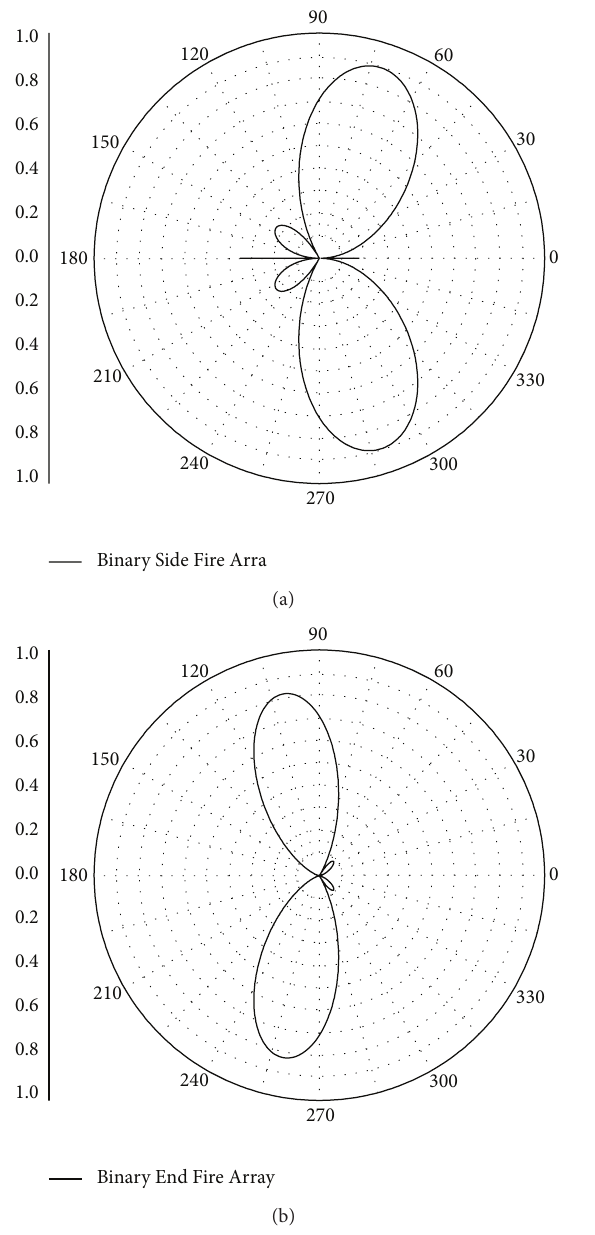
Figure 3: Radiation pattern of arrays calculated by MATLAB. (a) Binary Side Fire Array and (b) Binary End Fire Array. left with side lobe towards right. So by controlling phase of each array 𝜑 and 𝛾 , radiation direction can be controlled.